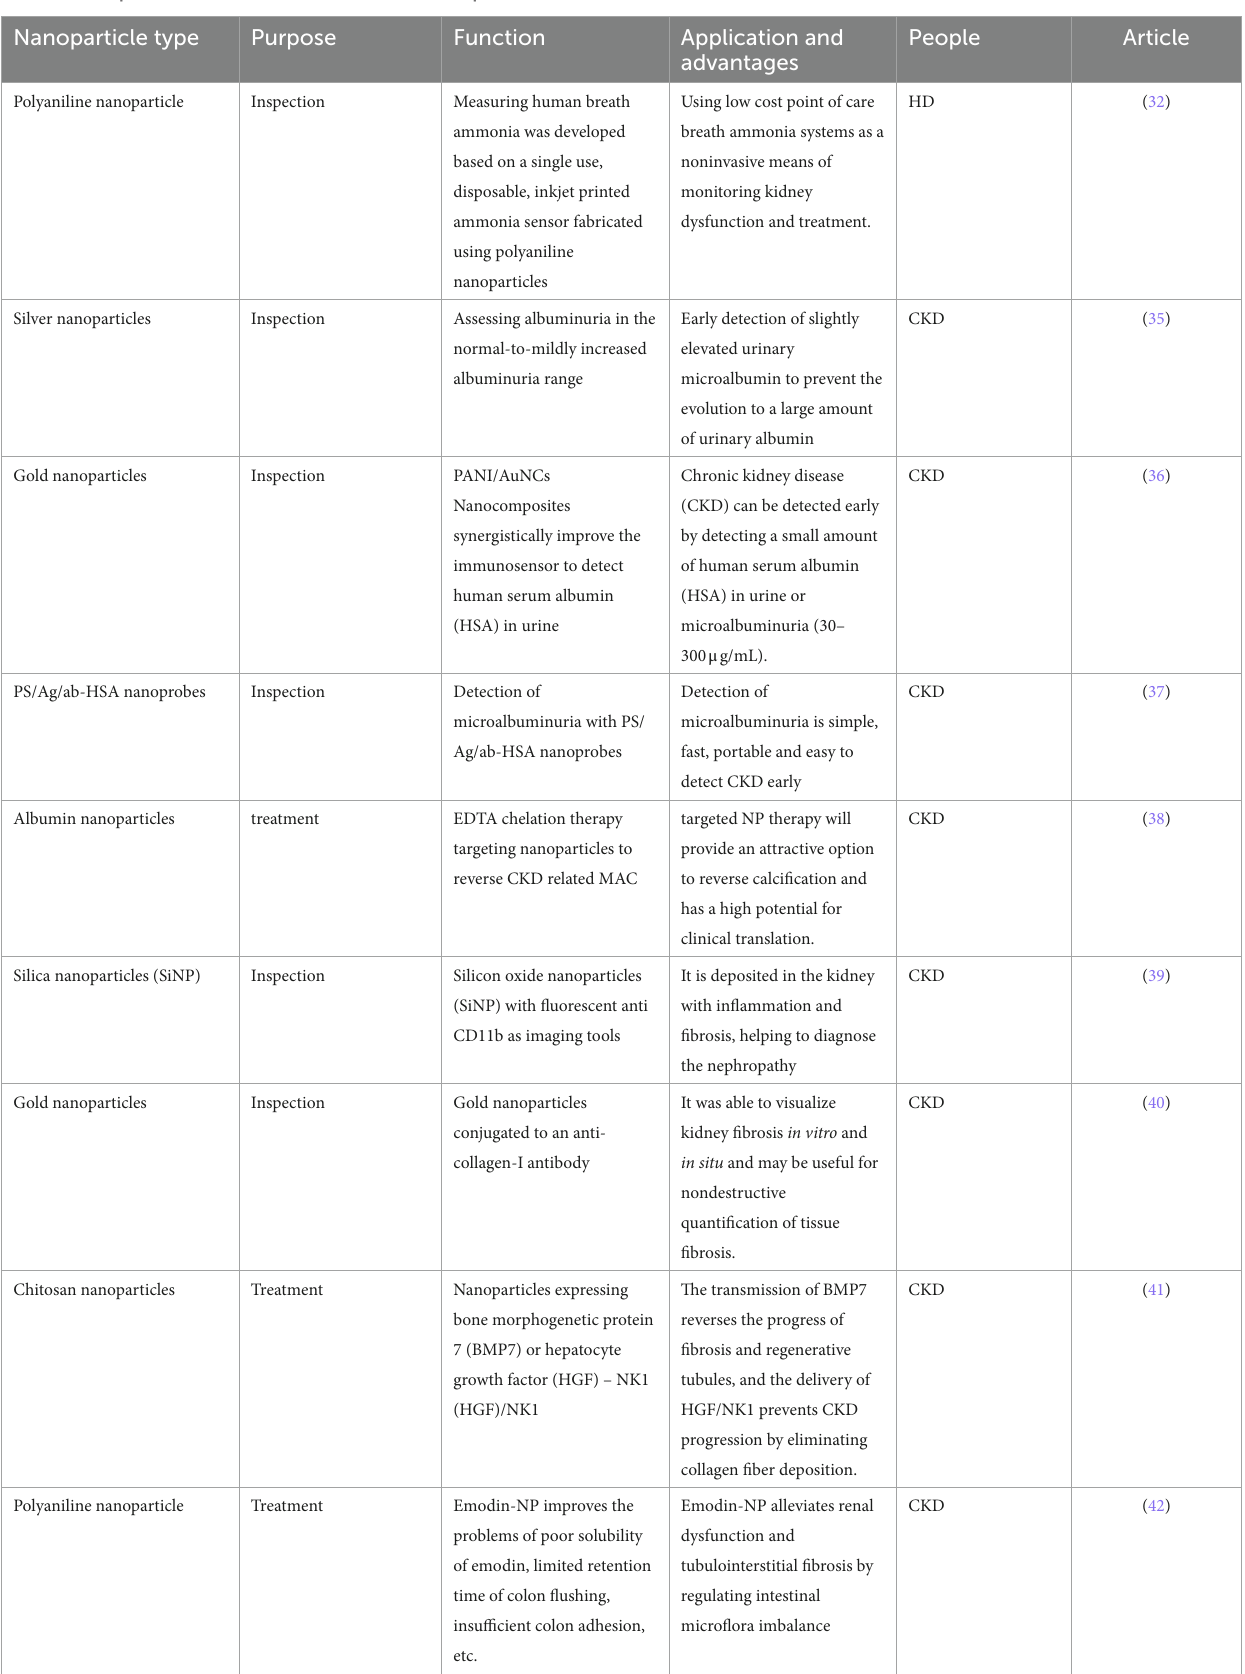
TABLE 1 Examples of clinical studies about different nanoparticles in the